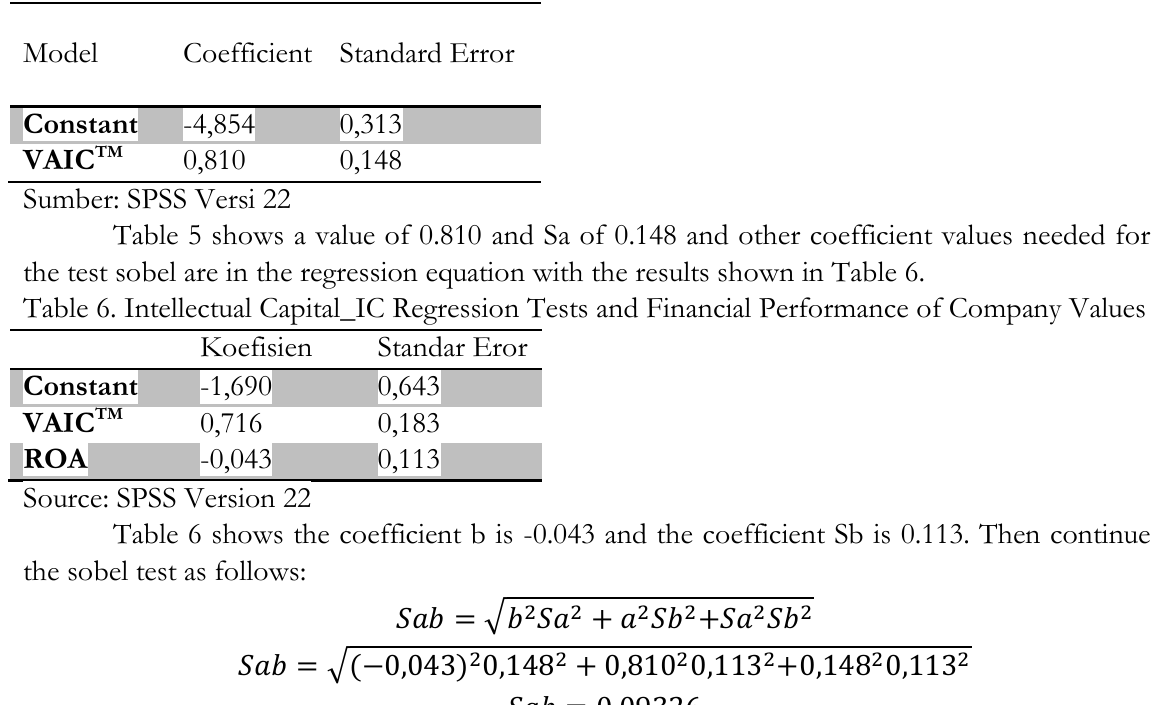
Table 5. Intellectual Capital Regression Tests on Financial Performance